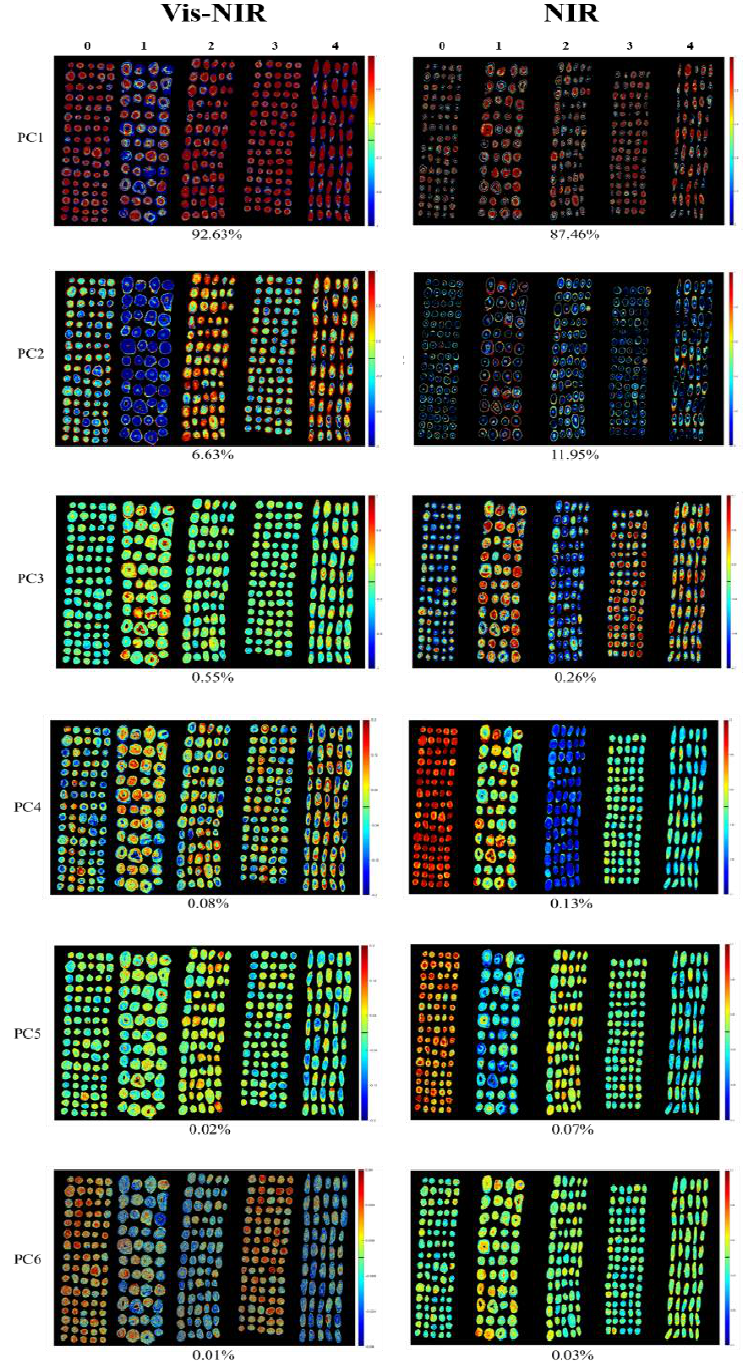
Figure 5. Principal component analysis (PCA) score images of the first six PCs for Radix Astragali from five geographical origins. (Left side: PCA score images of hyperspectral images in the Vis-NIR region; Right side: PCA score images of hyperspectral images in the NIR region).